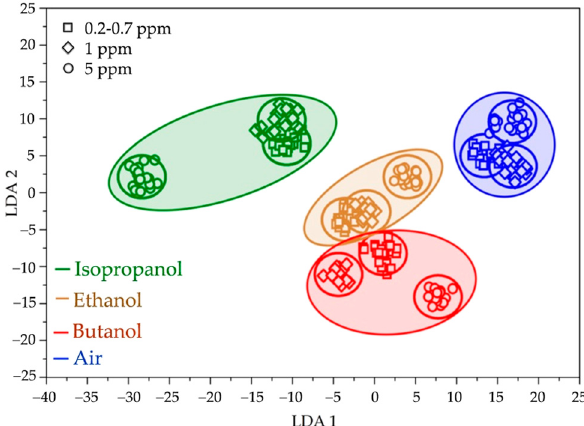
Figure 8: LDA plot showing that the electronic nose can recognize the di ff erent gases at di ff erent concentrations, from sub - ppm to 5 ppm. Reprinted with permission from ref. [ 49 ]